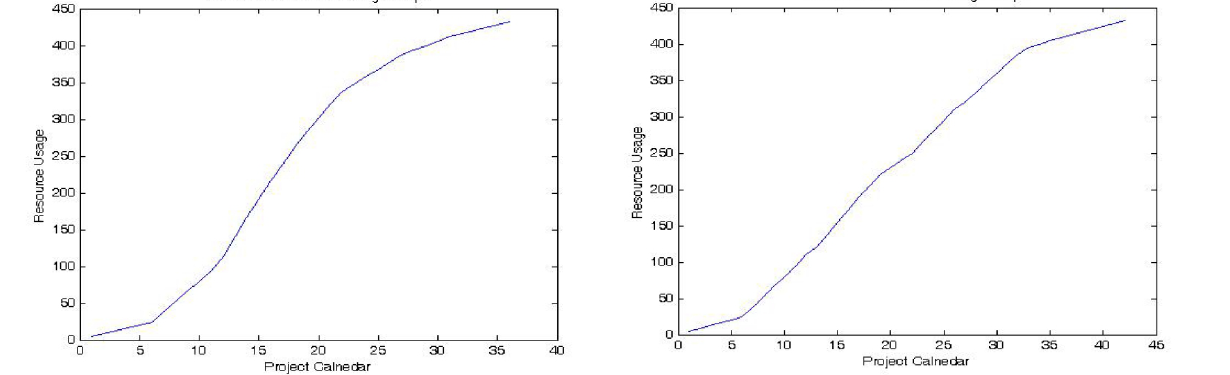
Figure 11. Cumulative resource usage for resource 1 of experiment 1 (after using forward